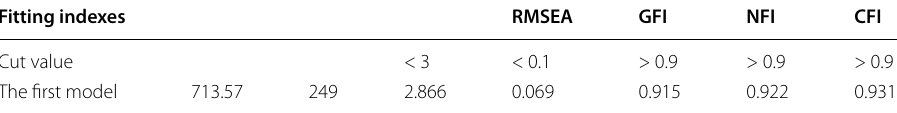
Table 3 Model fit indices Fitting indexes Cut value The first